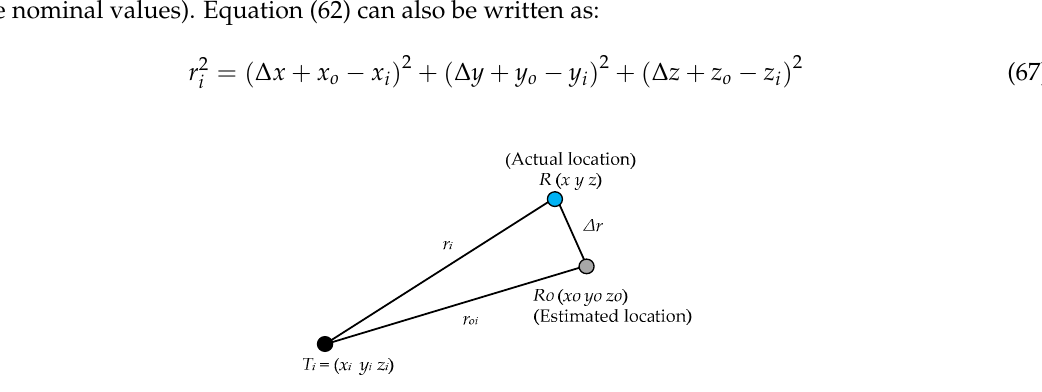
Figure 11. Actual and estimated position of receiver.